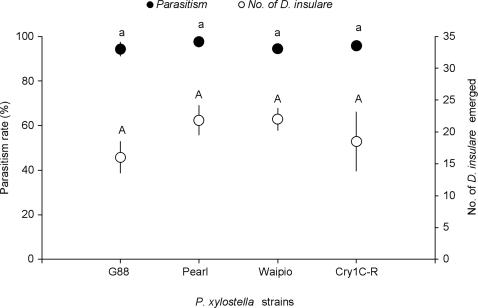
Parasitism rate (%) and the number of Diadegma insulare emerged from different untreated Plutella xylostella strains.Means (±SE) marked with different lower-case letters or capital letters are significantly different based on Fisher's LSD mean separation test (P<0.05).